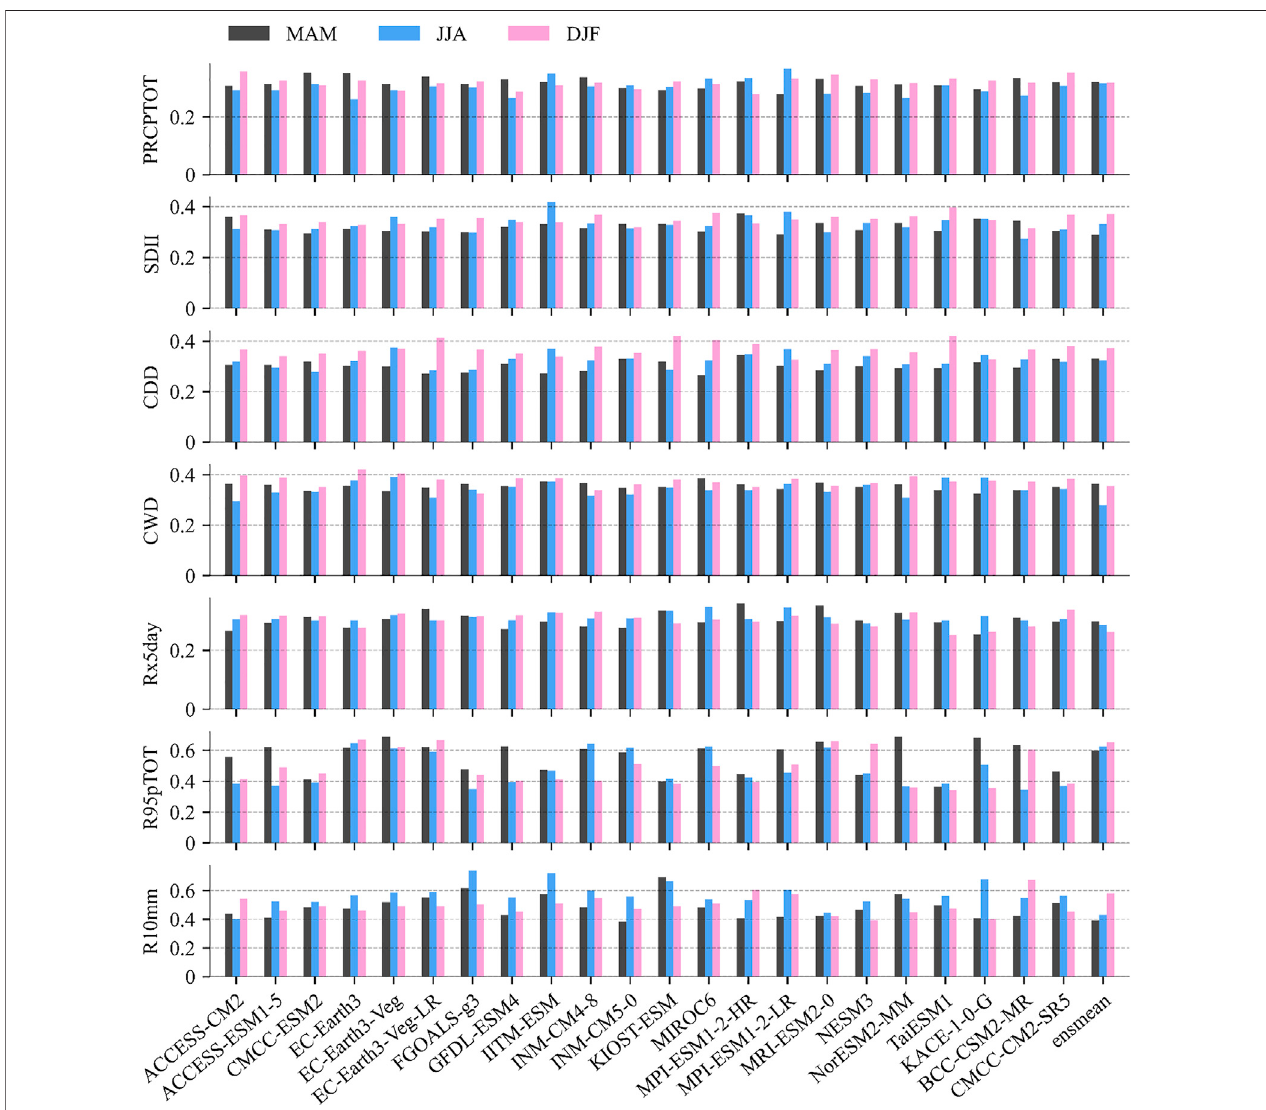
FIGURE 8 | Hellinger distance in L-skewness and L-kurtosis between bivariate empirical densities of CMIP6 models and the GPM.